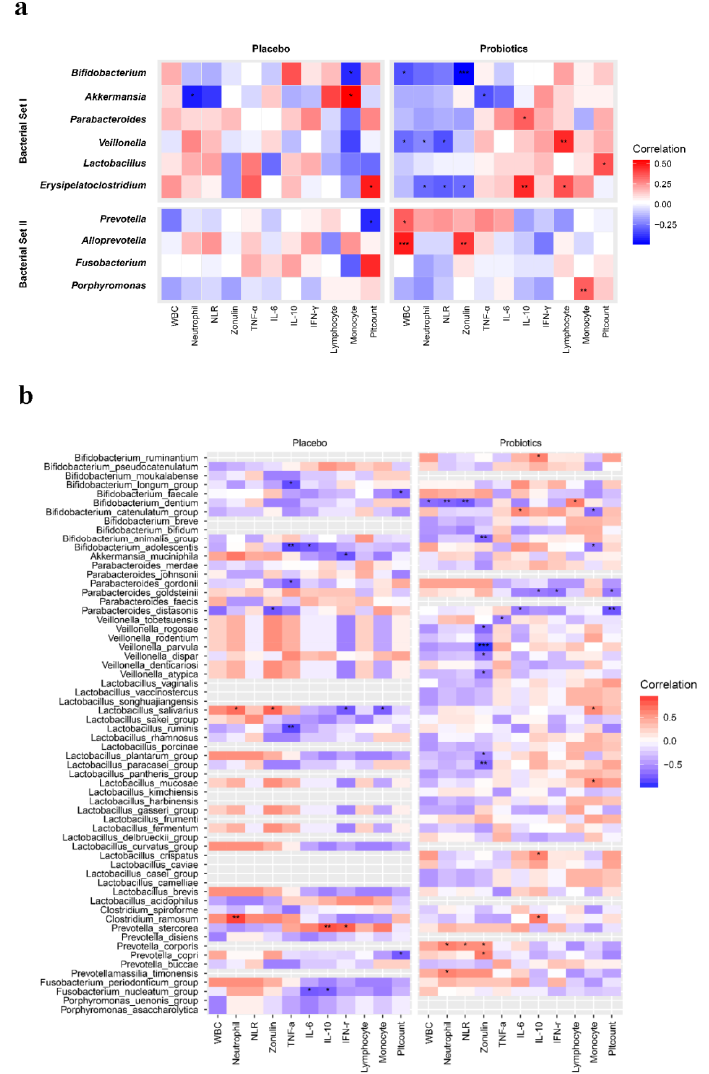
Figure 4. Spearman correlation analysis between clinical data and bacterial sets for the probiotics and placebo groups. ( a ) Bacterial Set I negatively correlated to WBC, neutrophils, NLR, and zonulin. Conversely, Bacterial Set II showed a reverse correlation. No correlation between biomarkers and bacterial sets composition showed in the placebo group. ( b ) Spearman correlation analysis in bacterial species level with biomarkers. WBC, white blood cells; NLR, neutrophil-lymphocyte ratio; IFN, interferon; TNF, tumor necrosis factor; IL, interleukin.